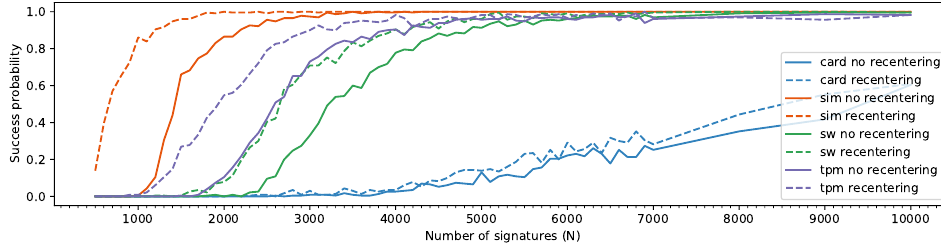
Figure 9: Success rate (averaged over all analyzed dimensions) of SVP with and without recentering, using geometric